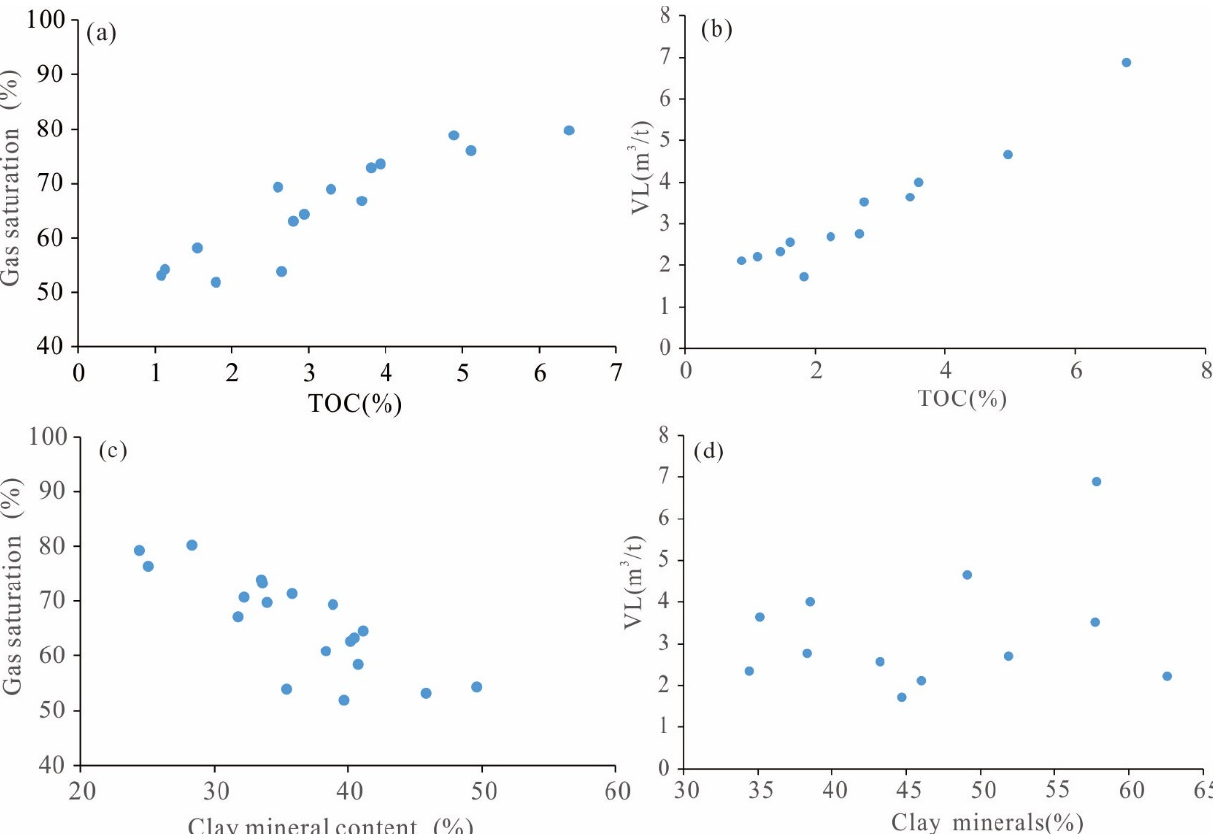
Figure 8. Effect of organic pores ( a , b ) and clay-mineral pores on gas content and adsorption capacity ( c , d ) in the Silurian Longmaxi marine-shale samples.